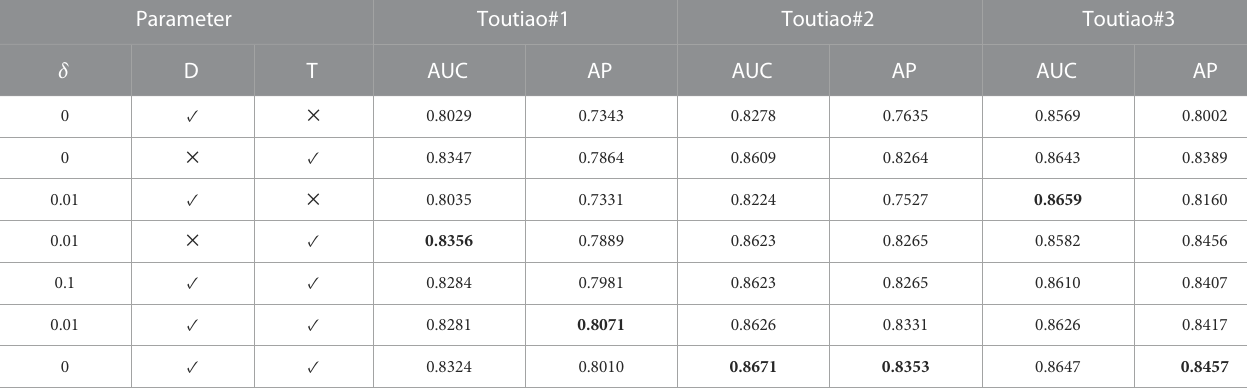
TABLE 4 Performance of different parameters of the NCU-GCN method among three subsets with respect to AUC and AP. Parameter